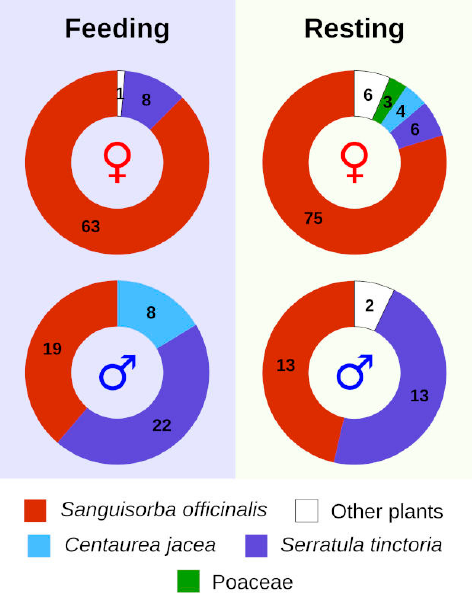
Figure 3. Plant species used for feeding and resting by Phengaris teleius during the tracking study. The numbers within the graph represent sample sizes, while symbols denote females ( ♀ ) and males ( ♂ ).